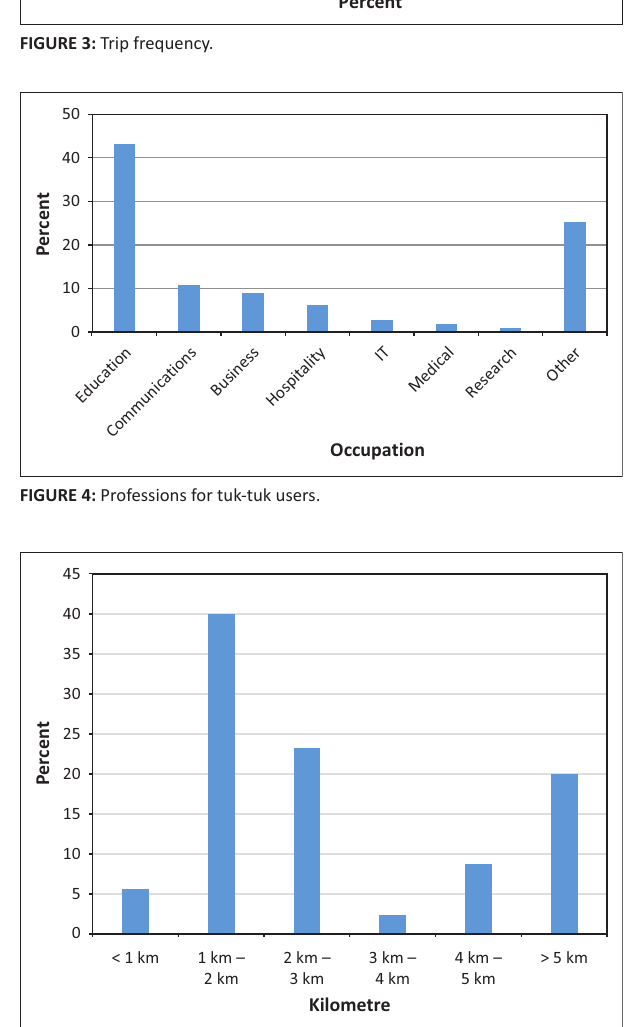
FIGURE 5: Trips taken by distance.